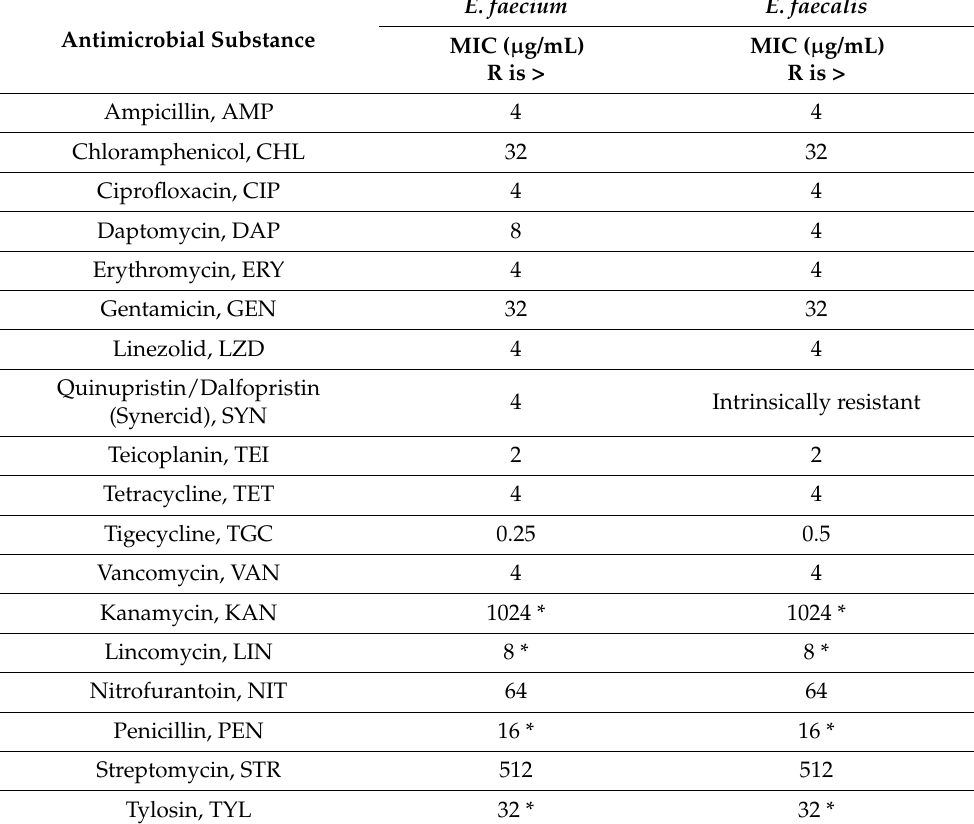
Table 1. Breakpoints for Enterococcus faecalis and Enterococcus faecium according to EURL guidelines adopted from EUCAST [24] and CLSI [25]. E. Antimicrobial Substance